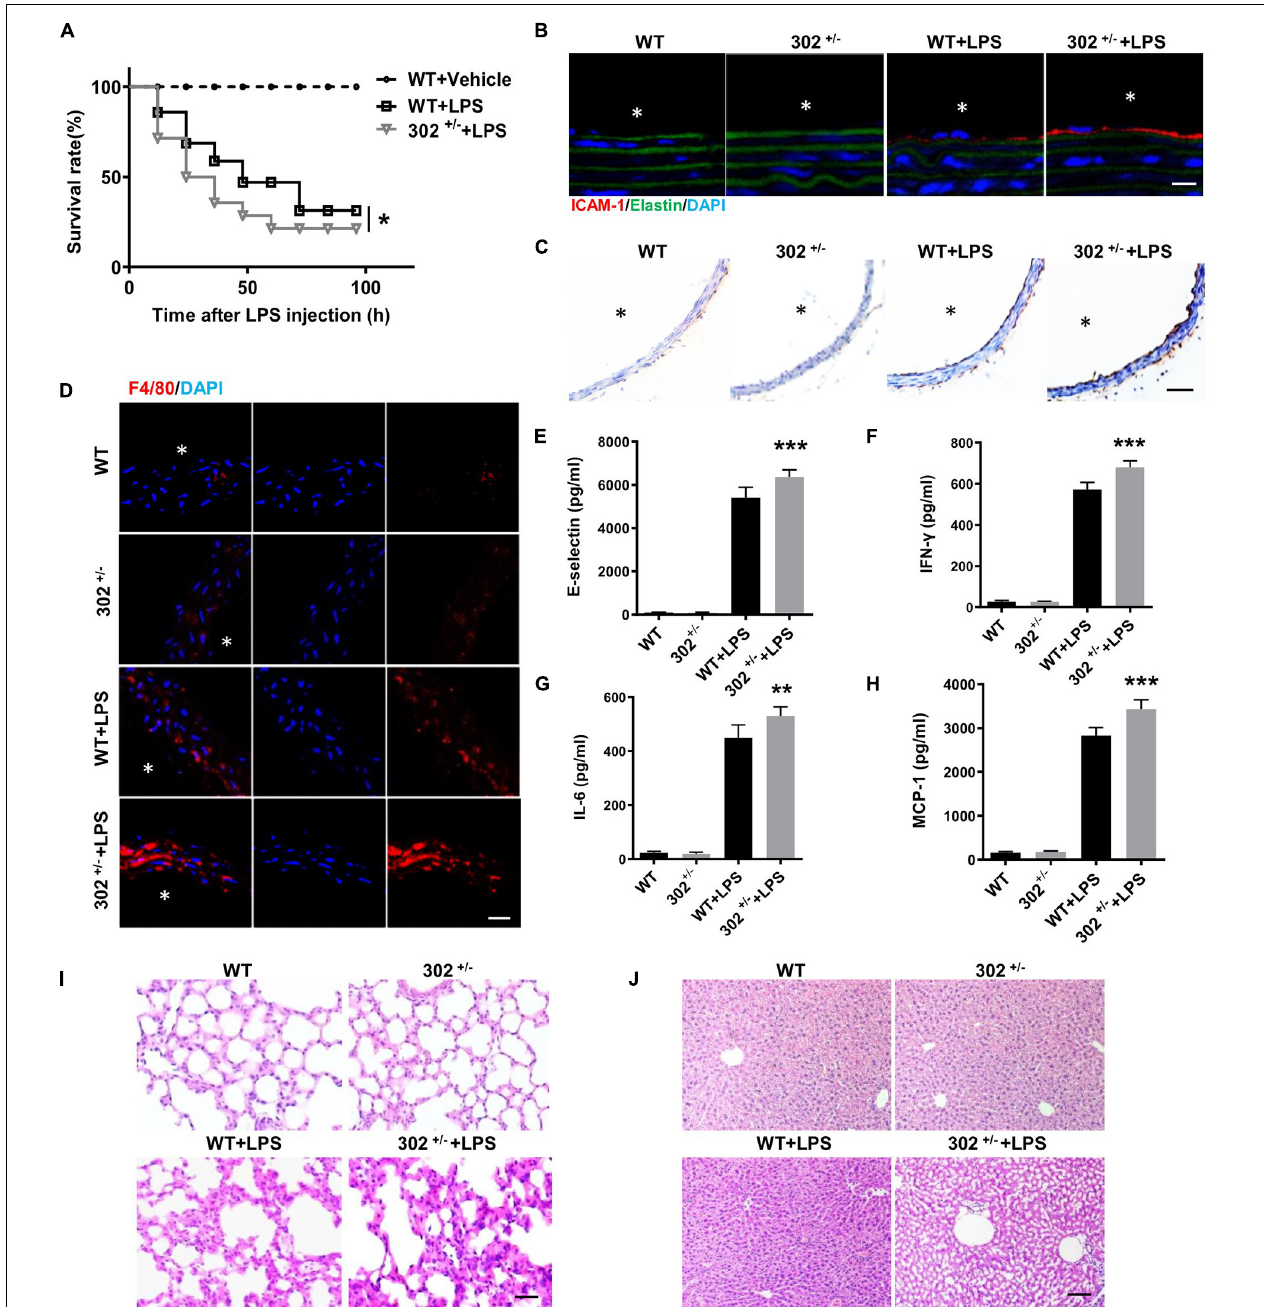
FIGURE 2 | Deficiency of miR-302 accelerates lipopolysaccharide (LPS)-induced vascular inflammation. (A) The survival rate of 8-weeks miR-302 + / − mice (302 + / − ) and WT mice after LPS injection (25 mg/kg), n = 20. (B) The expression of ICAM-1 in aorta from WT and miR-302 + / − mice was detected by immunofluorescence, n = 5, scale bar, 10 µ m, asterisk indicates the lumen of aorta. (C) Immunohistochemical staining of aorta VCAM-1 from WT and miR-302 + / − mice injected with LPS, n = 6, scale bar, 100 µ m. (D) Immunofluorescence staining of F4/80 represents the infiltration of macrophages (red) in the aorta, nuclei were counterstained with DAPI (blue), n = 5, scale bar, 50 µ m. The level of inflammatory factors E-selectin (E) , IFN- γ (F) , IL-6 (G) , and MCP-1 (H) in serum from miR-302 + / − mice and WT mice, n = 6. The inflammatory status of lung (I) and liver (J) stained by HE staining, n = 6. Scale bar, 100 µ m (* p < 0.05; ** p < 0.01; *** p < 0.001 vs. WT +